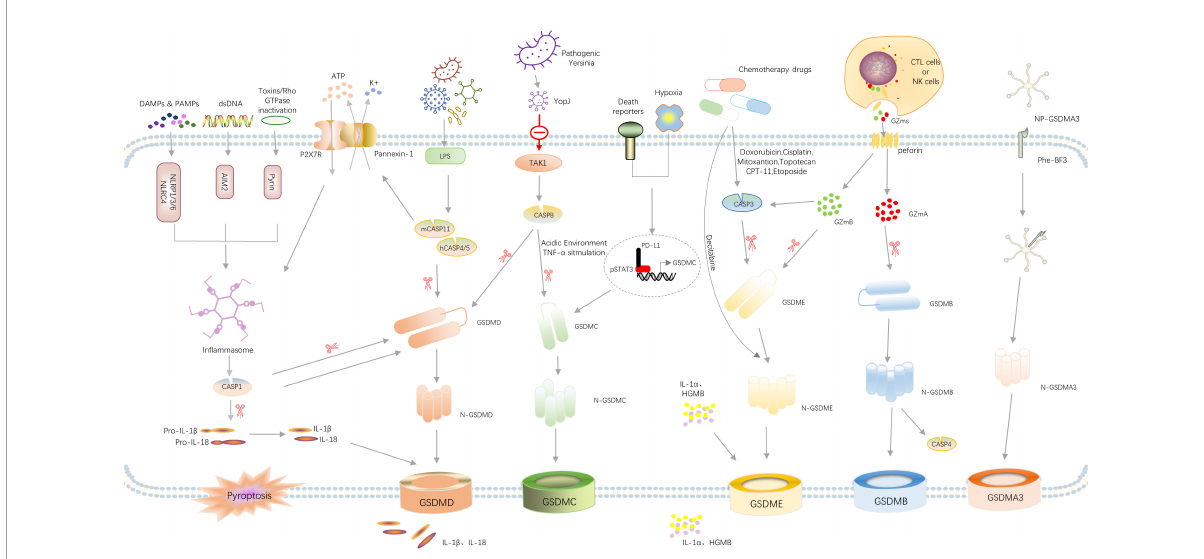
FIGURE2 Overview of signaling pathways that mediate pyroptosis. Recognition of pathogen-associated molecular patterns (PAMPs) or danger-associated molecular patterns (DAMPs) or double-stranded DNA (dsDNA) by their respective inflammasome-sensors NLRP1/3/6, NLRC4, AIM2, and Pyrin leads to the assembly of a multi-protein complex termed the inflammasome. Consequently, caspase-1 undergoes autoproteolytic processing to lock the protease in its active form. Caspase-1 directly cleaves its substrates gasdermin D and the pro-inflammatory cytokines pro-IL-1 β and pro-IL-18. The N-terminal cleavage fragment of Gsdmd forms pores in the host cell membrane thereby mediating the release of cytoplasmic content, the mature IL-1 β and IL-18 and the other DAMPs IL-1 α , HMGB1 and ATP. Cytosolic LPS activates caspase-4/5 and caspase-11, triggering pyroptosis by cleaving GSDMD. The activated caspase-11 also cleaves Pannexin-1, inducing ATP release and P2 × 7R-related pyroptotic cell death. Pathogenic Yersinia can inhibit TAK1 function by effector YopJ, and then induces the activation of caspase-8, which cleaves GSDMD, resulting in pyroptosis. In addition, under hypoxia conditions, PD-L1 is transferred to the nucleus and regulates the transcription of GSDMC together with p-Stat3, resulting in the conversion of apoptosis to pyroptosis after TNF α -activated caspase-8. Chemotherapy drugs can activate caspase-3 to cleave GSDME and induce pyroptosis. In the granzyme-mediated pathway, CAR T cells rapidly activate caspase-3 in target cells by releasing GzmB, and then GSDME was activated, causing extensive pyroptosis. In addition, GzmA and GzmB in cytotoxic lymphocytes enter target cells through perforin and induce pyroptosis. GzmA hydrolyzes GSDMB, and GzmB directly activates GSDME. The administration of NP-GSDMA3 and Phe-BF3 induces GSMDA3-mediated pyroptosis. GSDMA acts as both a sensor and substrate of GAS SpeB and as an effector to trigger